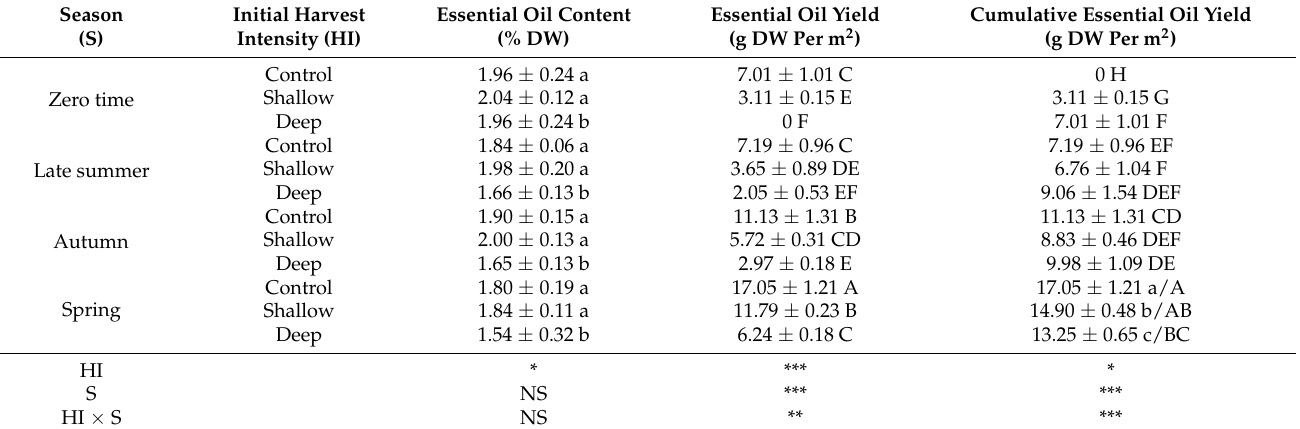
Table 3. Oil content (% DW), essential oil yield (g DW per m 2 ) and cumulative oil yield (g DW per m 2